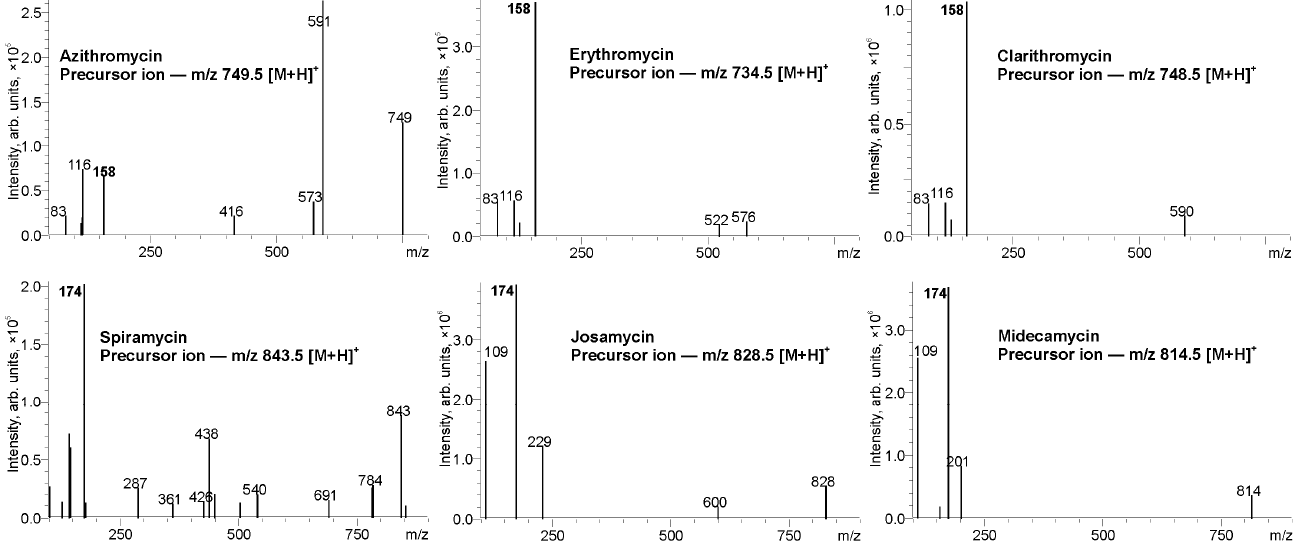
Figure 2. Tandem mass spectra of macrolides (collision energy 30 eV).